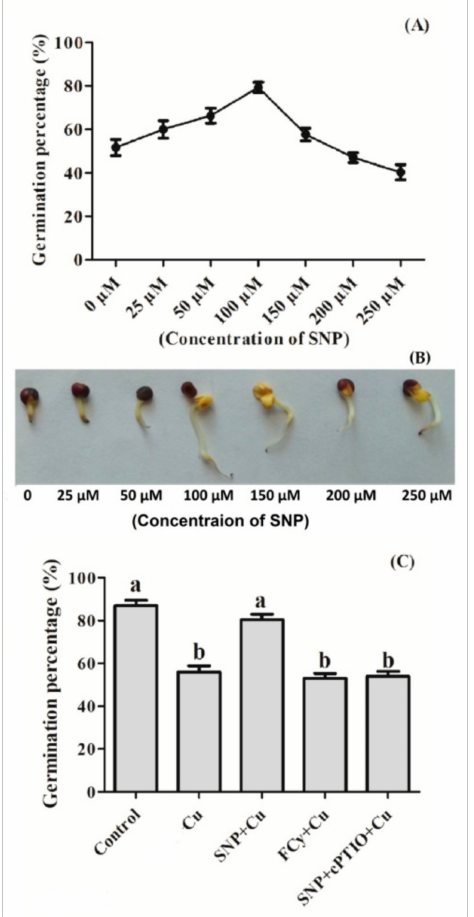
Figure 2. ( A ) Germination percentage under varying concentration of SNP under Cu stress; ( B ) phenotype of randomly selected germinating seeds of Indian mustard ( Brassica juncea L.) pre-treated with 0, 25, 50, 100, 150, 200, and 250 µ M SNP and exposed to 3.0 mM Cu; and ( C ) germination percentage in B. juncea seeds pre-treated with water, SNP, FCy (SNP analogue) and SNP + cPTIO (cPTIO as a specific NO-scavenger), later exposed to 3.0 mM Cu for 3 days. Same letter above bars show that data did not di ff er significantly by LSD test at p <